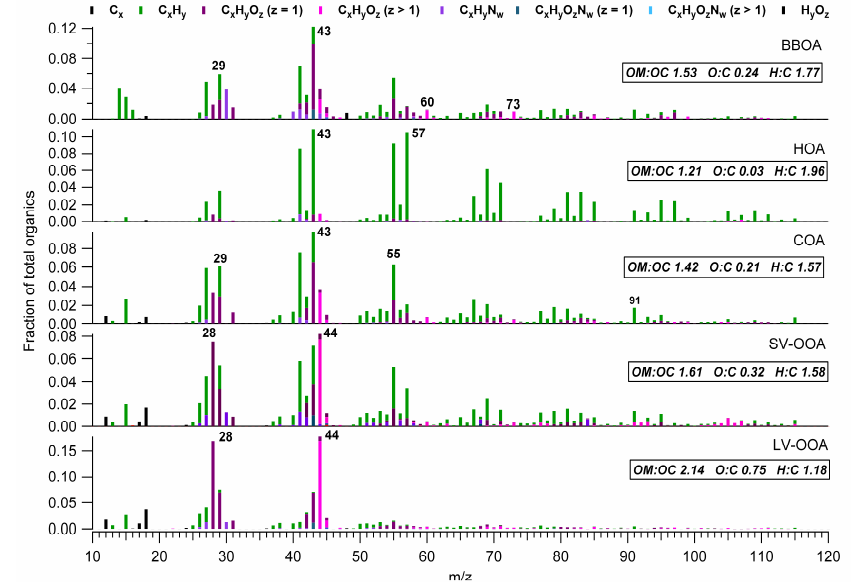
Fig. 2. Mass spectra of the 5-factor-PMF solution. The elemental ratios of the different factors are shown in boxes.